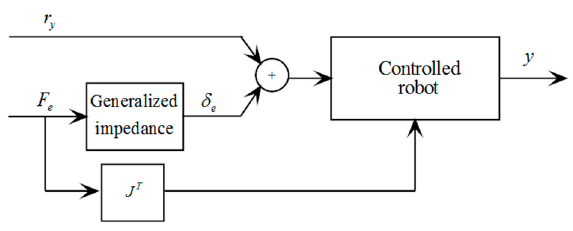
Figure 29. Impedance control scheme.